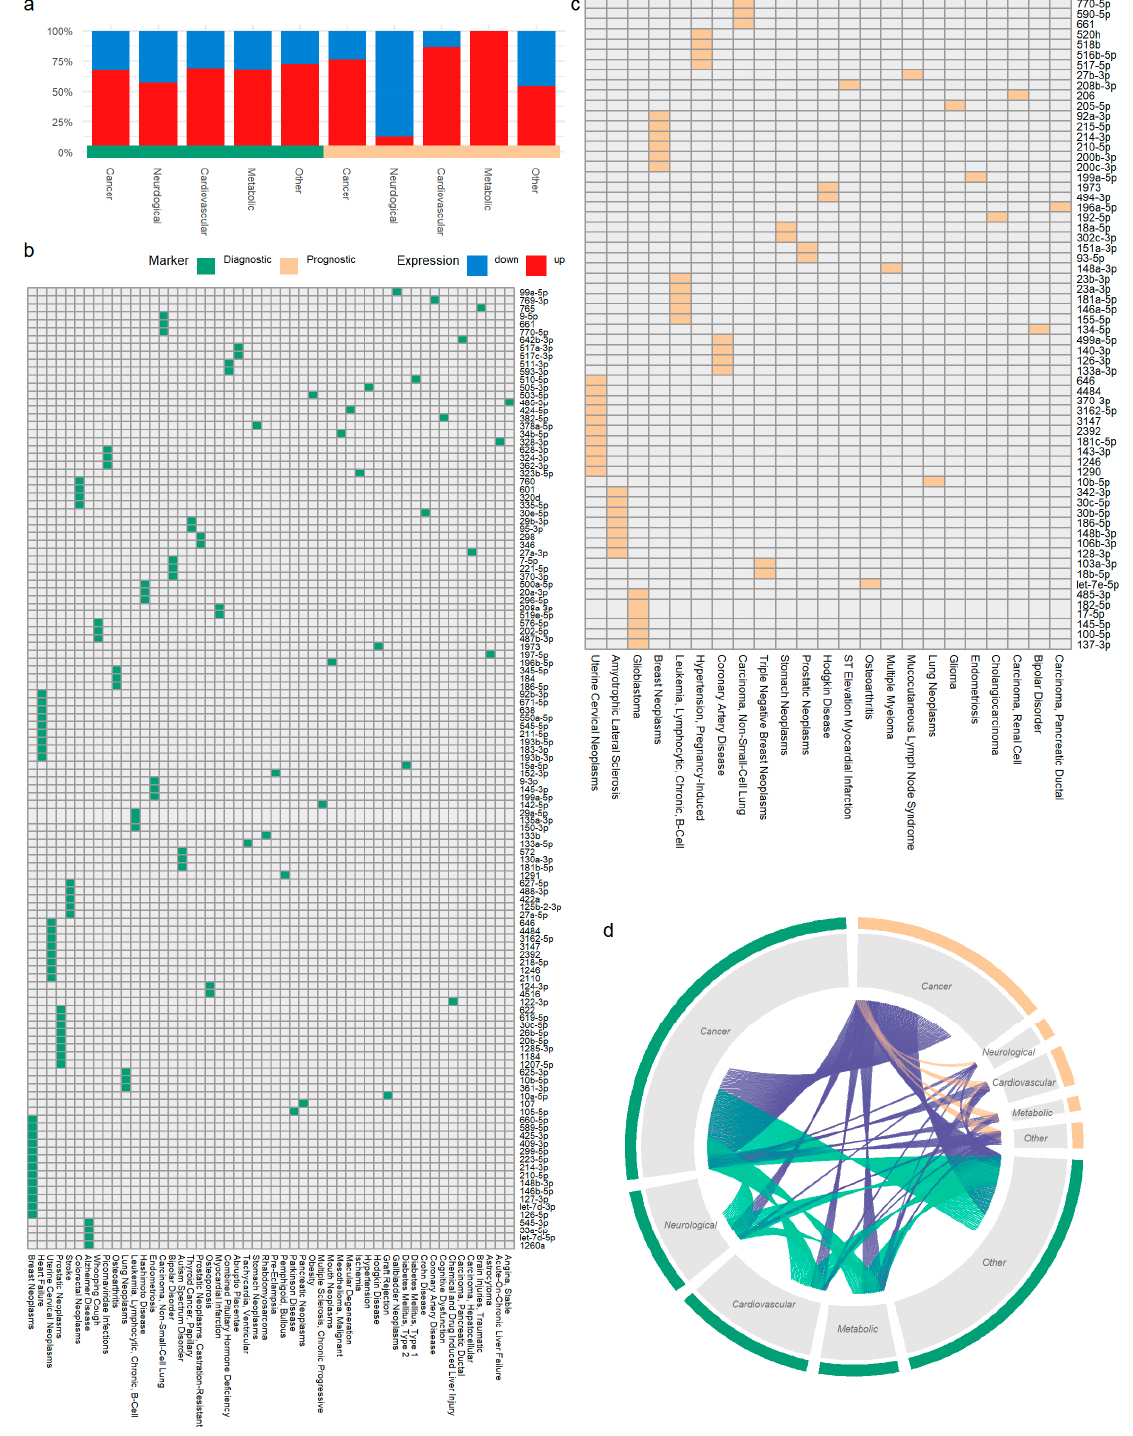
Figure 2. Composite view of the plasmiR content. ( a ) Percentage of up- (red) and down-regulated (blue) miRNAs in each disease category for diagnostic (green) and prognostic (light orange) entries. ( b ) Heatmap presenting 122 miRNAs annotated as diagnostic biomarkers against a single disease each (52 diseases). ( c ) Heatmap of 64 prognostic miRNAs against outcomes of 23 single diseases. ( d ) Entries are grouped by biomarker type (outer arcs, green: diagnostic, light orange: prognostic) and per disease category (inner grey arcs, cancers, neurological conditions, cardiovascular diseases, metabolic disorders, and other diseases). In the center of the plot, the number of strings that link distinct disease arcs matches the amounts of shared miRNAs across disease categories that are found to possess biomarker potential (green strings: diagnostic-diagnostic links, orange: prognostic-prognostic links, and purple: diagnostic-prognostic links).